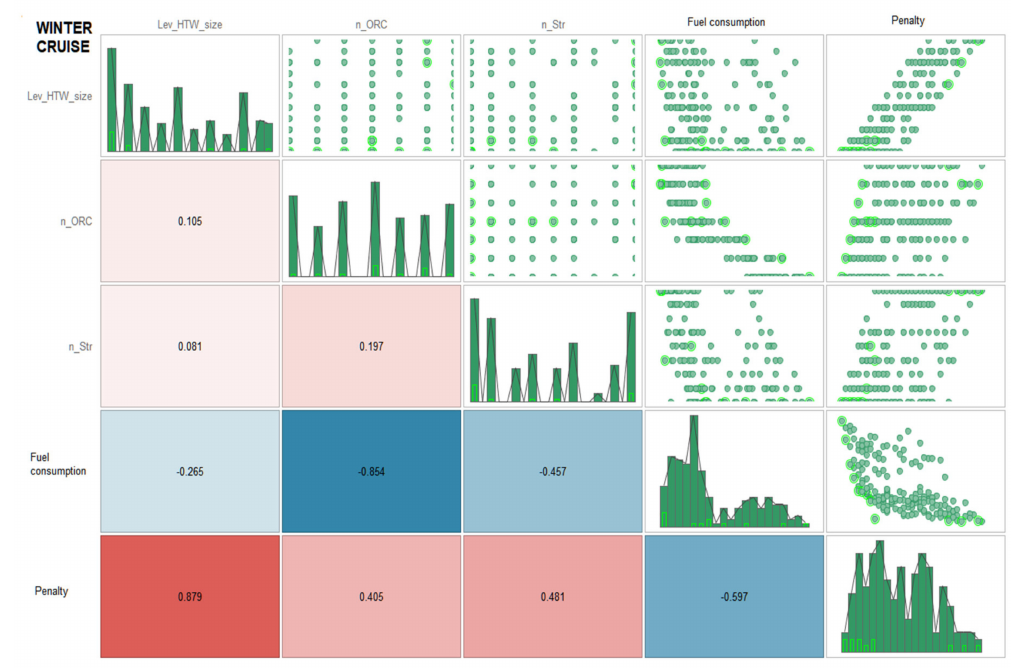
Figure 15. Scattering matrix of the solutions analyzed for the winter case.